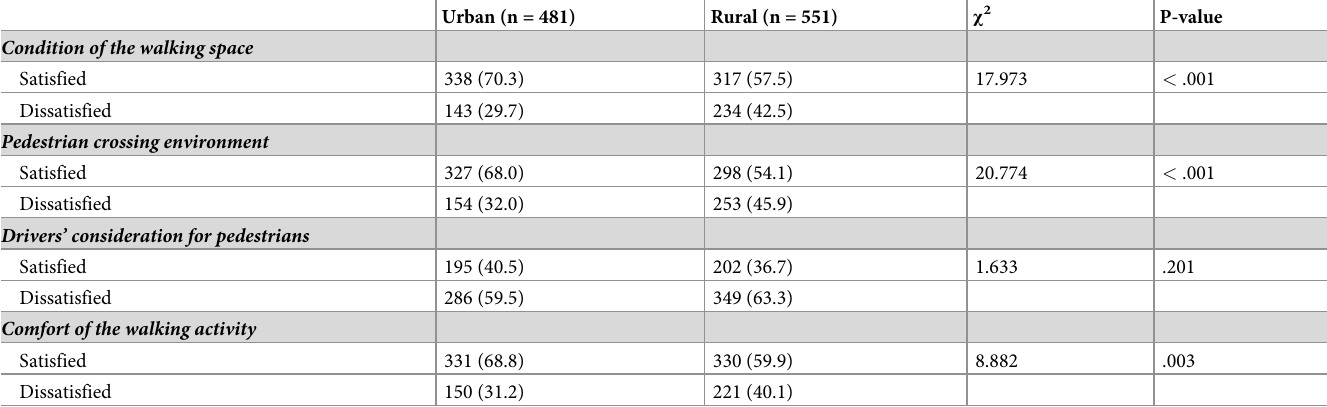
Table 2. Differences in the satisfaction of the walking-related environmental factors according to the residential area.